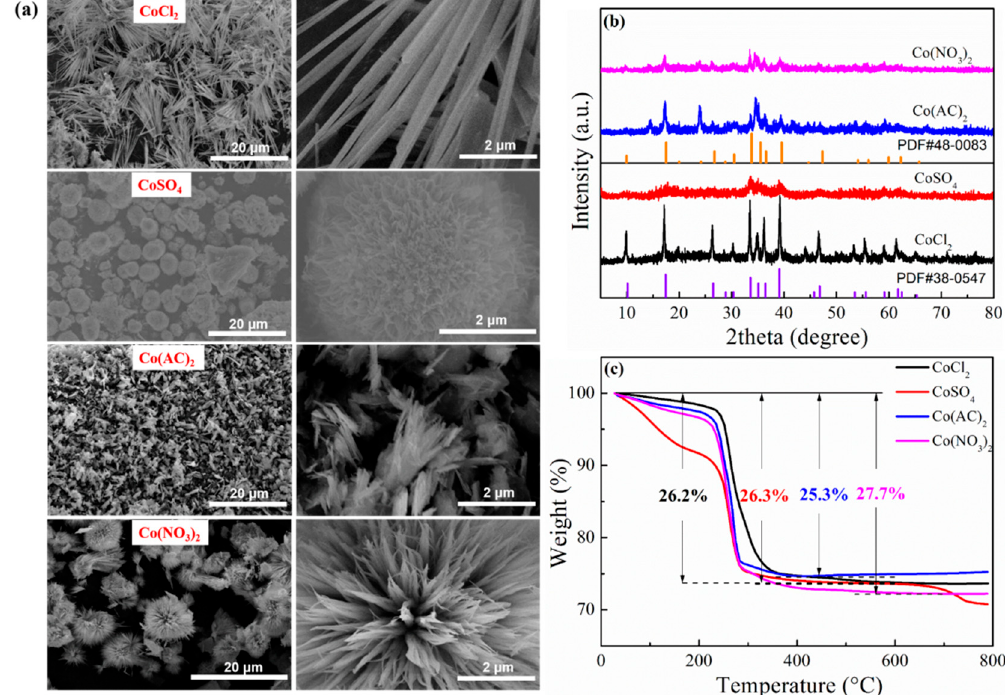
Figure 2. ( a ) Scanning electron microscope (SEM) images of the precursors obtained with cobalt chloride, cobalt sulfate, cobalt acetate, and cobalt nitrate as cobalt sources. ( b ) X-ray diffraction (XRD) patterns of the prepared precursors and ( c ) thermogravimetric (TG) curves of the synthesized precursors with different cobalt sources.